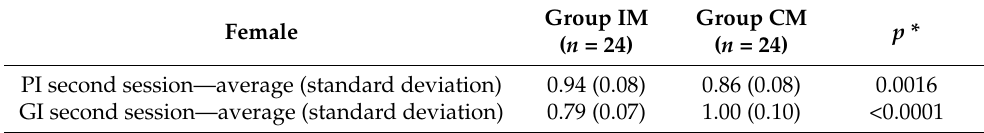
Table 11. Average (standard deviation) of PI and GI in the second monitoring session in female patients.